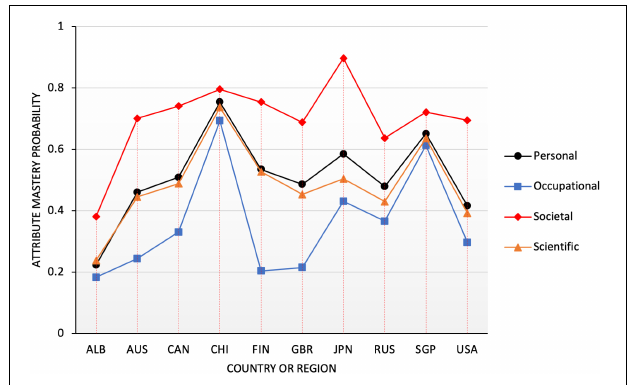
FIGURE 3 | Probability distribution map of 10 countries’ context